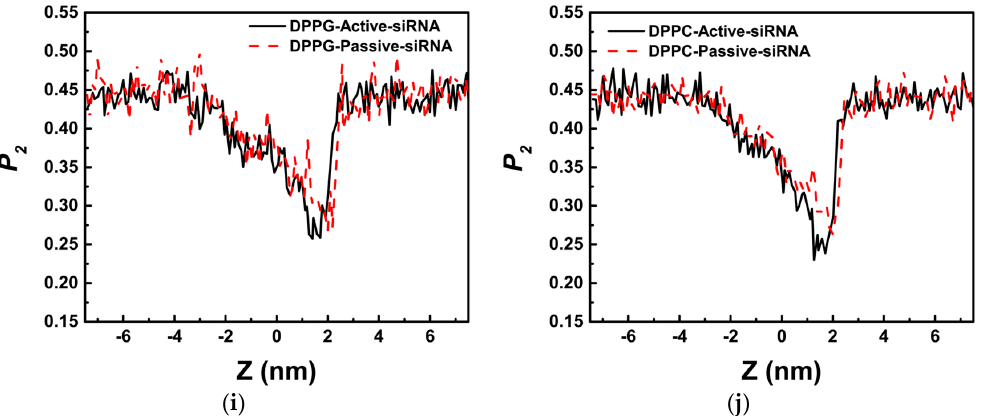
Figure 1. The transmembrane process of the naked siRNA where Z represents the distance between the mass center of siRNA and the center of lipid bilayer membrane along the Z direction as shown in Figure 9d. ( a ) Changes of contact area between siRNA and membrane; ( b ) solvent accessible surface area of lipid bilayer membrane; ( c ) the radius of gyration of the naked siRNA; ( d ) lipid number around the naked siRNA in the case of active transport; ( e ) lipid number around the naked siRNA in the case of passive transport; ( f ) Coulomb interaction energy between the naked siRNA and lipid bilayer membrane; ( g ) L–J interaction energy between the naked siRNA and lipid bilayer membrane; ( h ) total interaction energy between the naked siRNA and lipid bilayer membrane; ( i ) order parameter ( P 2 ) of DPPG molecules in lipid bilayer membrane; ( j ) order parameter ( P 2 ) of DPPC molecules in lipid bilayer membrane.